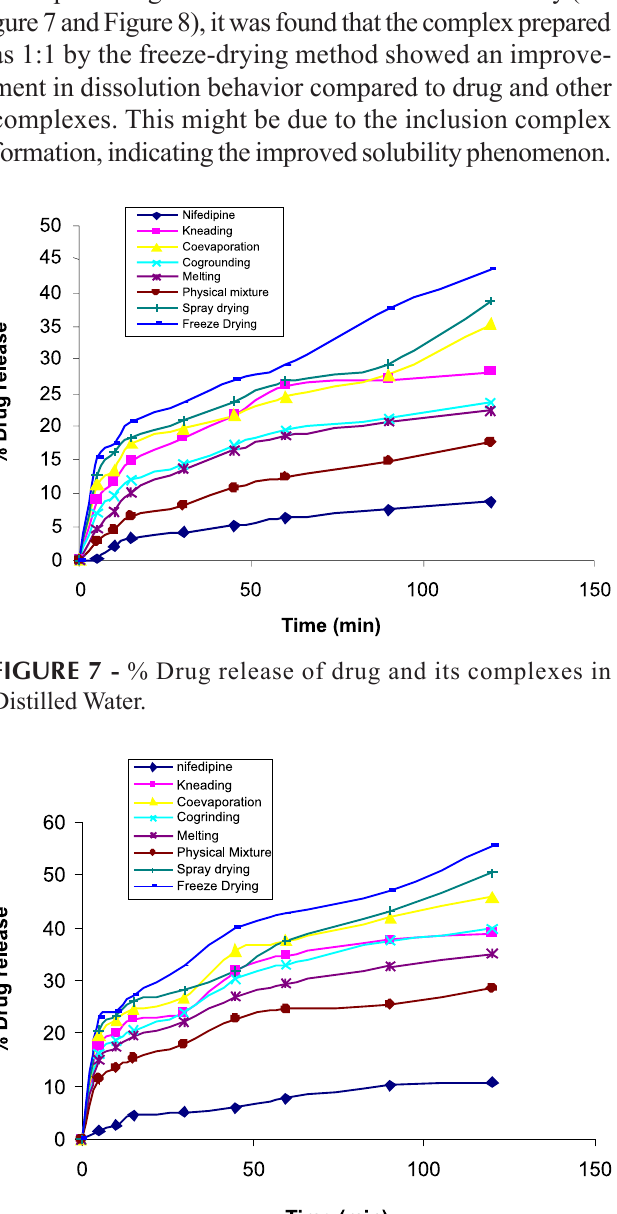
FIGURE 8 - % Drug release of drug and its complexes in Phosphate buffer at pH